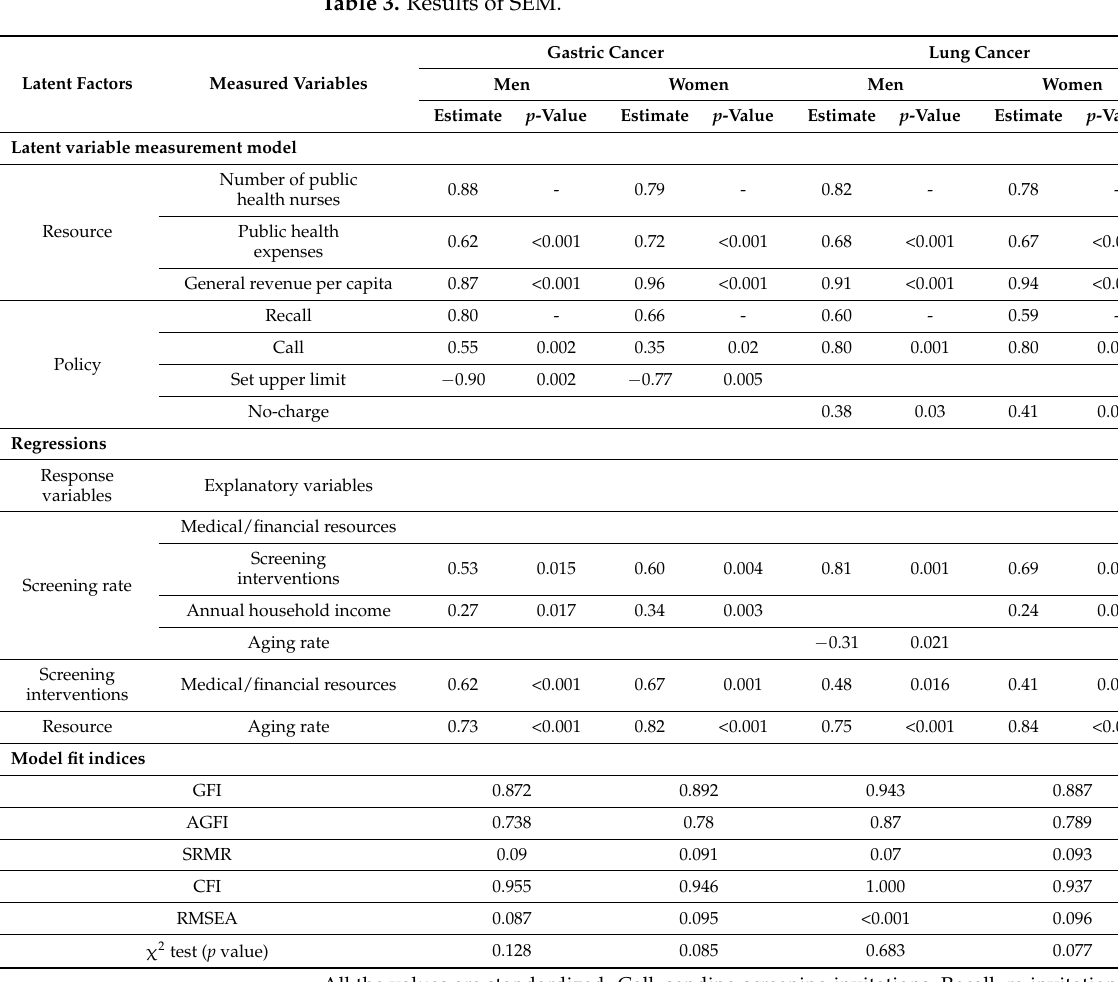
Table 3. Results of